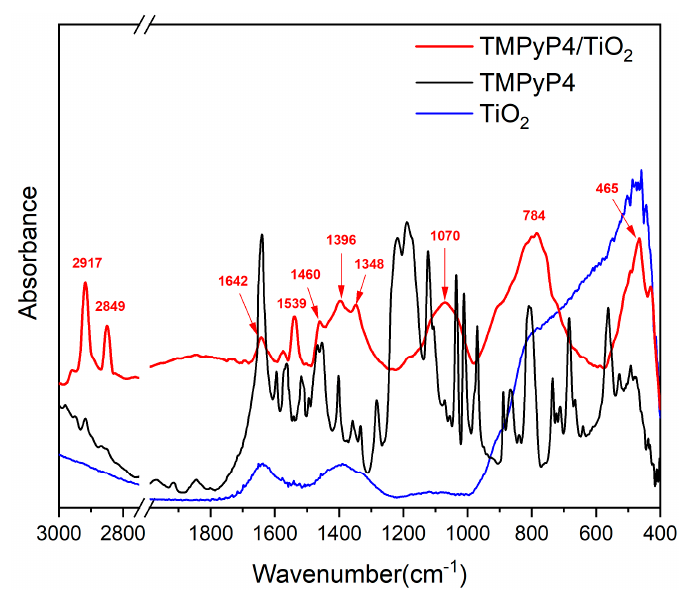
Figure 5. FTIR spectra of suspensions containing TiO 2 nanoparticles, TMPyP4, and TMPyP4-loaded TiO 2 nanoparticles.